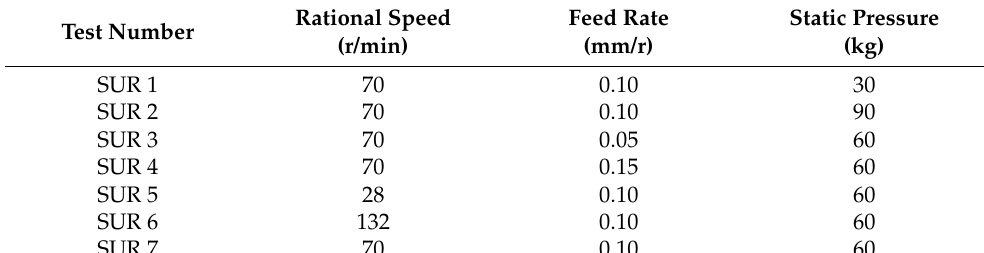
Figure 2. Surface ultrasonic rolling treatment of sample. Figure 3. Morphology of samples after surface ultrasonic rolling. Table 2. Parameters of surface ultrasonic rolling treatment using single-factor variable method.